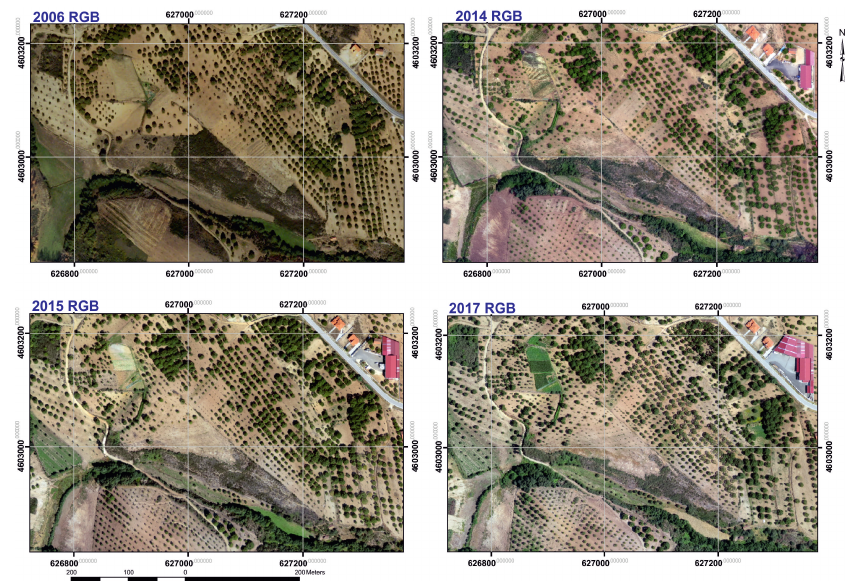
Figure 3. Temporal evolution of a portion of the study area in each campaign. RGB: red-green-blue.